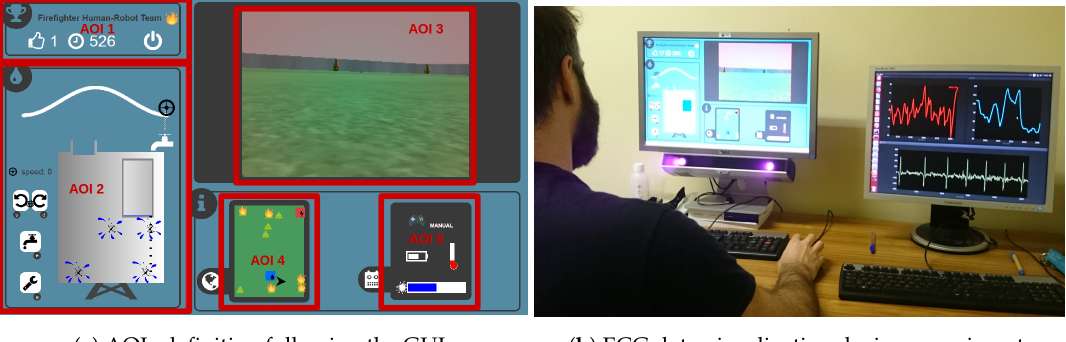
Figure 3. ( a ) Screenshot of the graphical user interface showing the areas of interest (AOIs) defined for the study; ( b ) ECG-data acquisition during the